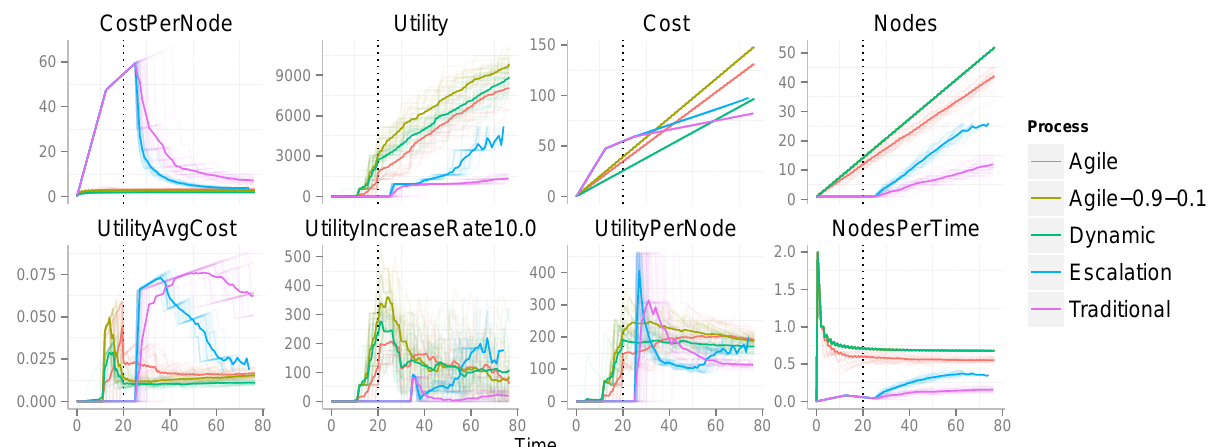
Figure 9. Graph of the performance of the Dynamic protocol compared to the more traditional ones. Metrics are the same as in Figure 8. All simulations were carried out on randomly generated trees with branching factor 4 and max depth 3, with a population of